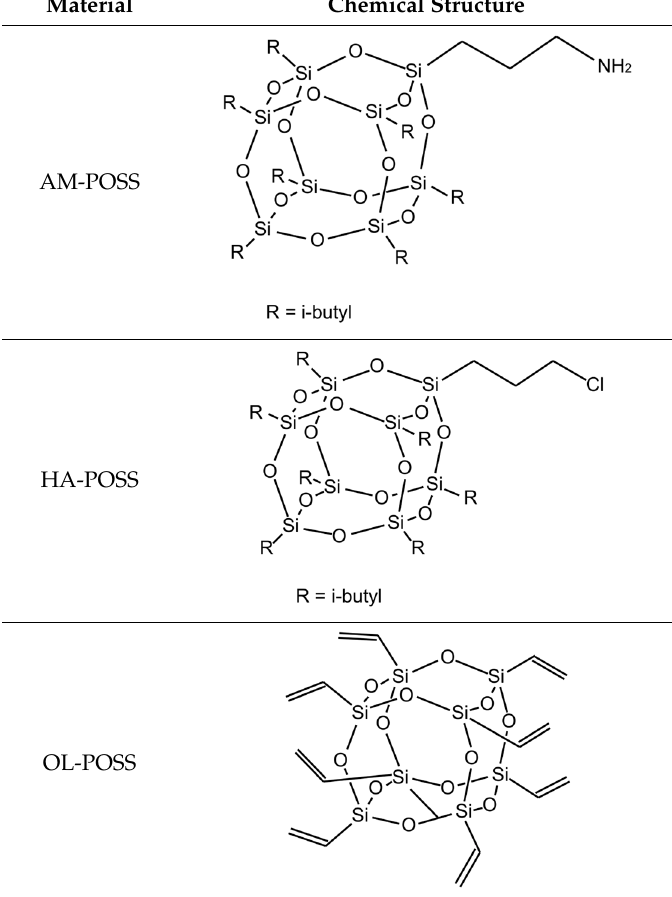
Table 2. Composition of the silicone (SR) rubber-based mixtures. Sample